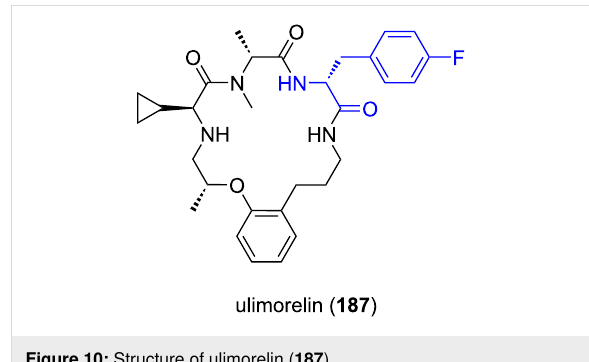
Figure 10: Structure of ulimorelin ( 187 ).